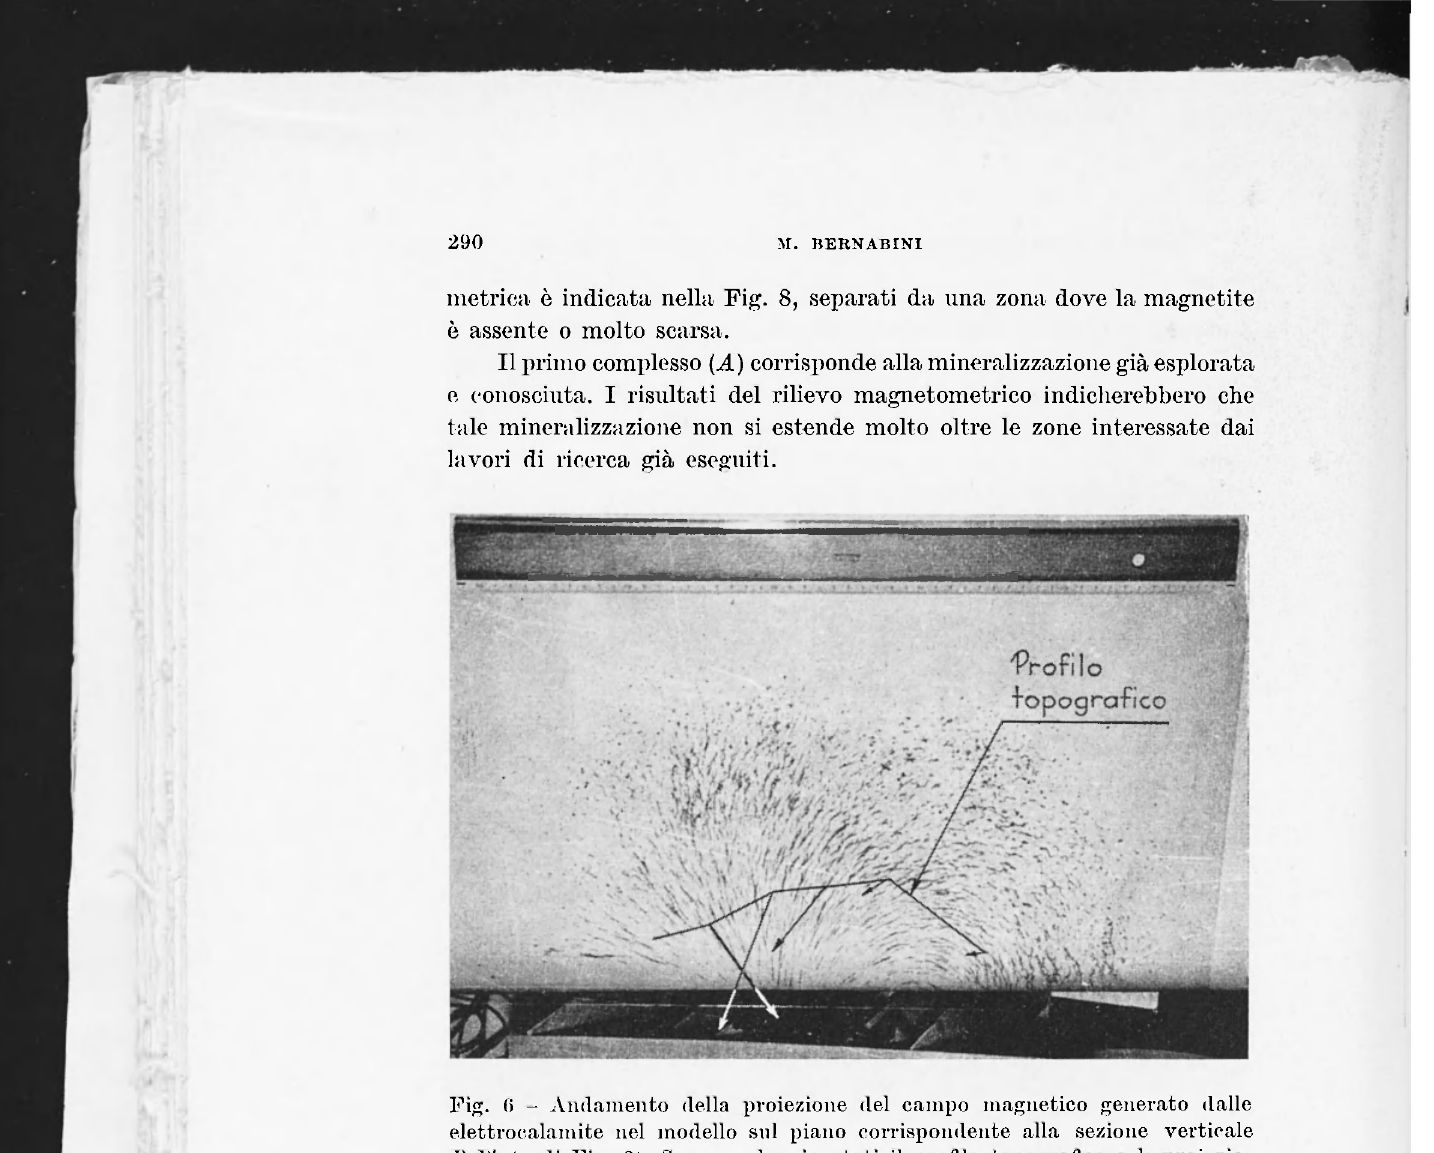
Fig. 6 - Andamento della proiezione del campo magnetico generato dalle elettrocalamite nel modello sul piano corrispondente alla sezione verticale B-li' (vedi Fig. 3). Sono anche riportati il profilo topografico e le proiezio- ni, sulla sezione, dei vettori anomali totali determinati nelle varie stazio- ni interessate dalla sezione